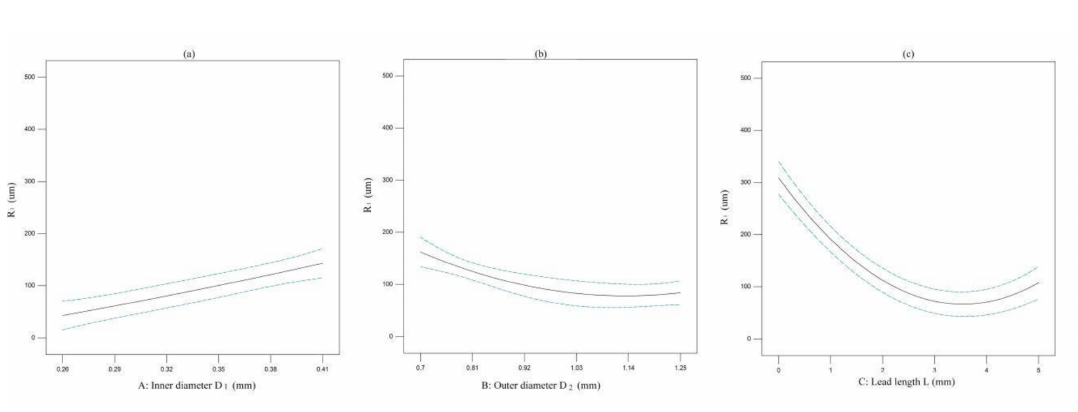
Figure 6. The e ff ect of one factor for the diameter of biomaterial. ( a ) inner cavity diameter, ( b ) outer cavity diameter, ( c ) lead length.